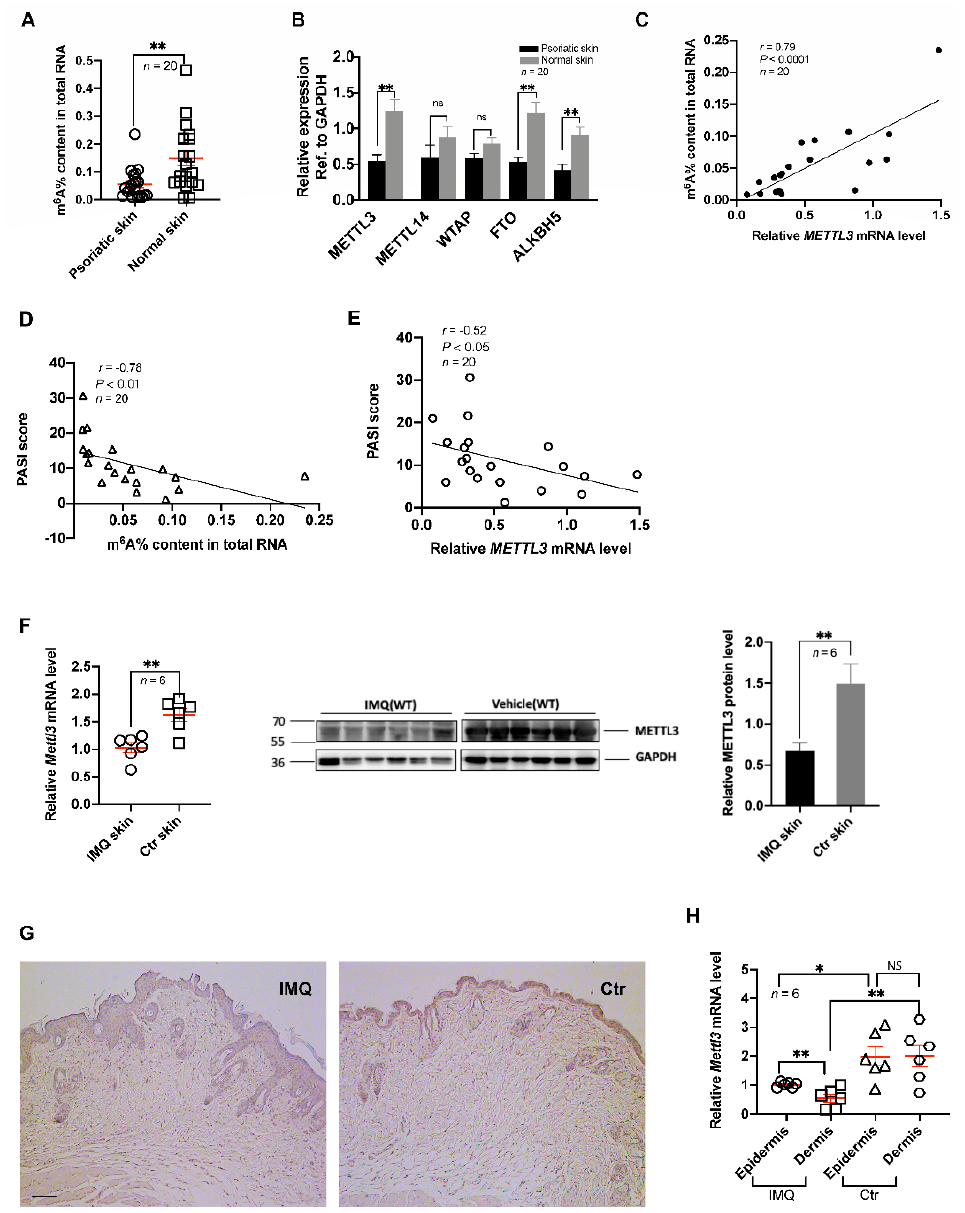
Figure 1. Downregulation of m 6 A and METTL3 levels in psoriatic skin lesions. ( A ) The m 6 A